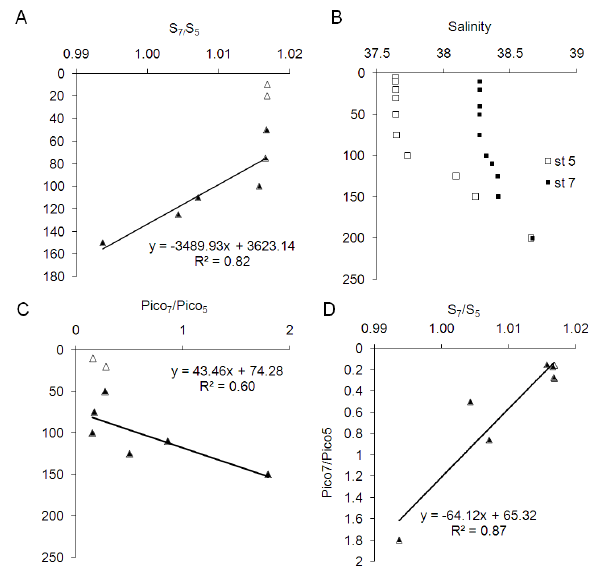
Fig. 13: Relationships between vertical distributions of picoeukaryote (Pico) abundance and salinity in the western (station 5) and eastern (station7) Mediterranean Sea. (A) Depth dependence of the salinity ratio S 7 /S 5 . (B) Vertical distribution of salinity. (C) Depth dependence of the abundance ratio Pico 7 /Pico 5 . (D) Relationship between picoeukaryote abundance ratio Pico 7 /Pico 5 and salinity ratio S 7 /S 5 .